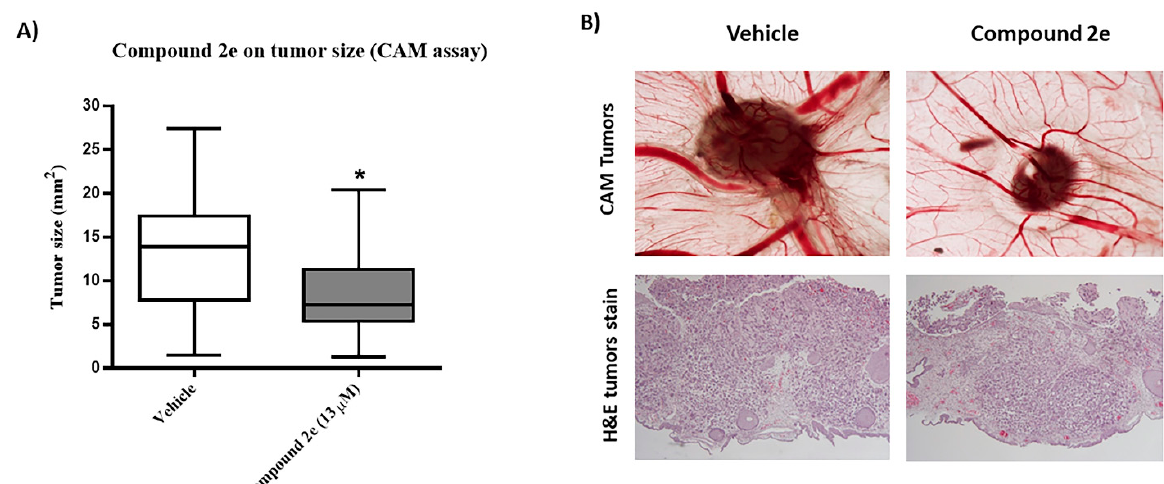
Figure 4. Effect of compound 2e on tumor size, using the in ovo chick embryo chorioallantoic membrane (CAM) model. TNBC MDA-MB-231 cells were grafted in the chicken eggs, and after 24 h were treated with the vehicle (DMSO) or with the compound 2e at 13 µ M, for 48 h. ( A ) Tumor size of eggs treated with vehicle and compound 2e . Data is from two independent experiments. * p ≤ 0.05 of Vehicle vs. Treatment. ( B ) Representative images (1.25 × amplification) or Hematoxylin & Eosin (H&E) stain of tumor size of cells treated with vehicle (DMSO) and compound 2e